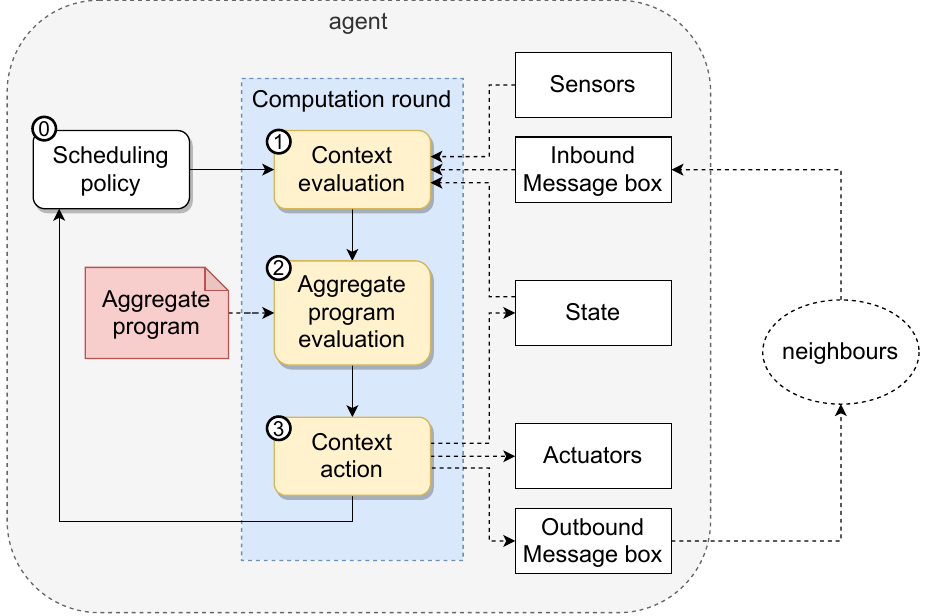
Figure 1. Agent control architecture in aggregate programming. Notation: square boxes denote components; rounded boxes denote activities; dashed rounded boxes denote agents; solid arrows denote control passing; dashed arrows denote data